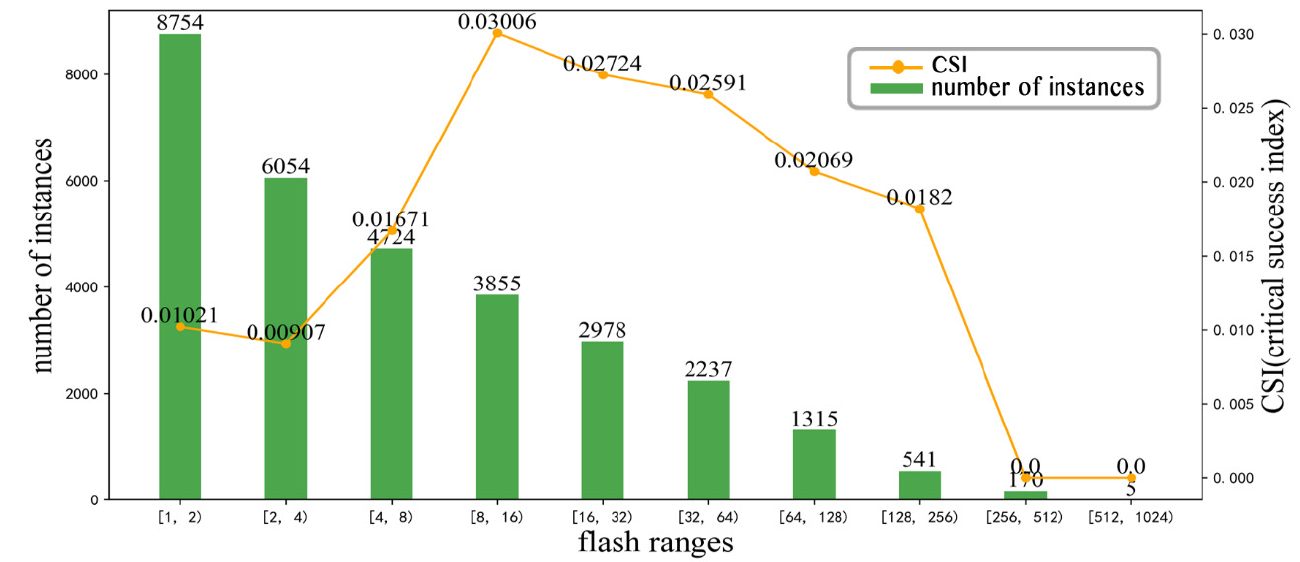
Figure 2. The impacts analysis of the change in the threshold values of lightning frequency on the performance of data sample filtering algorithm.